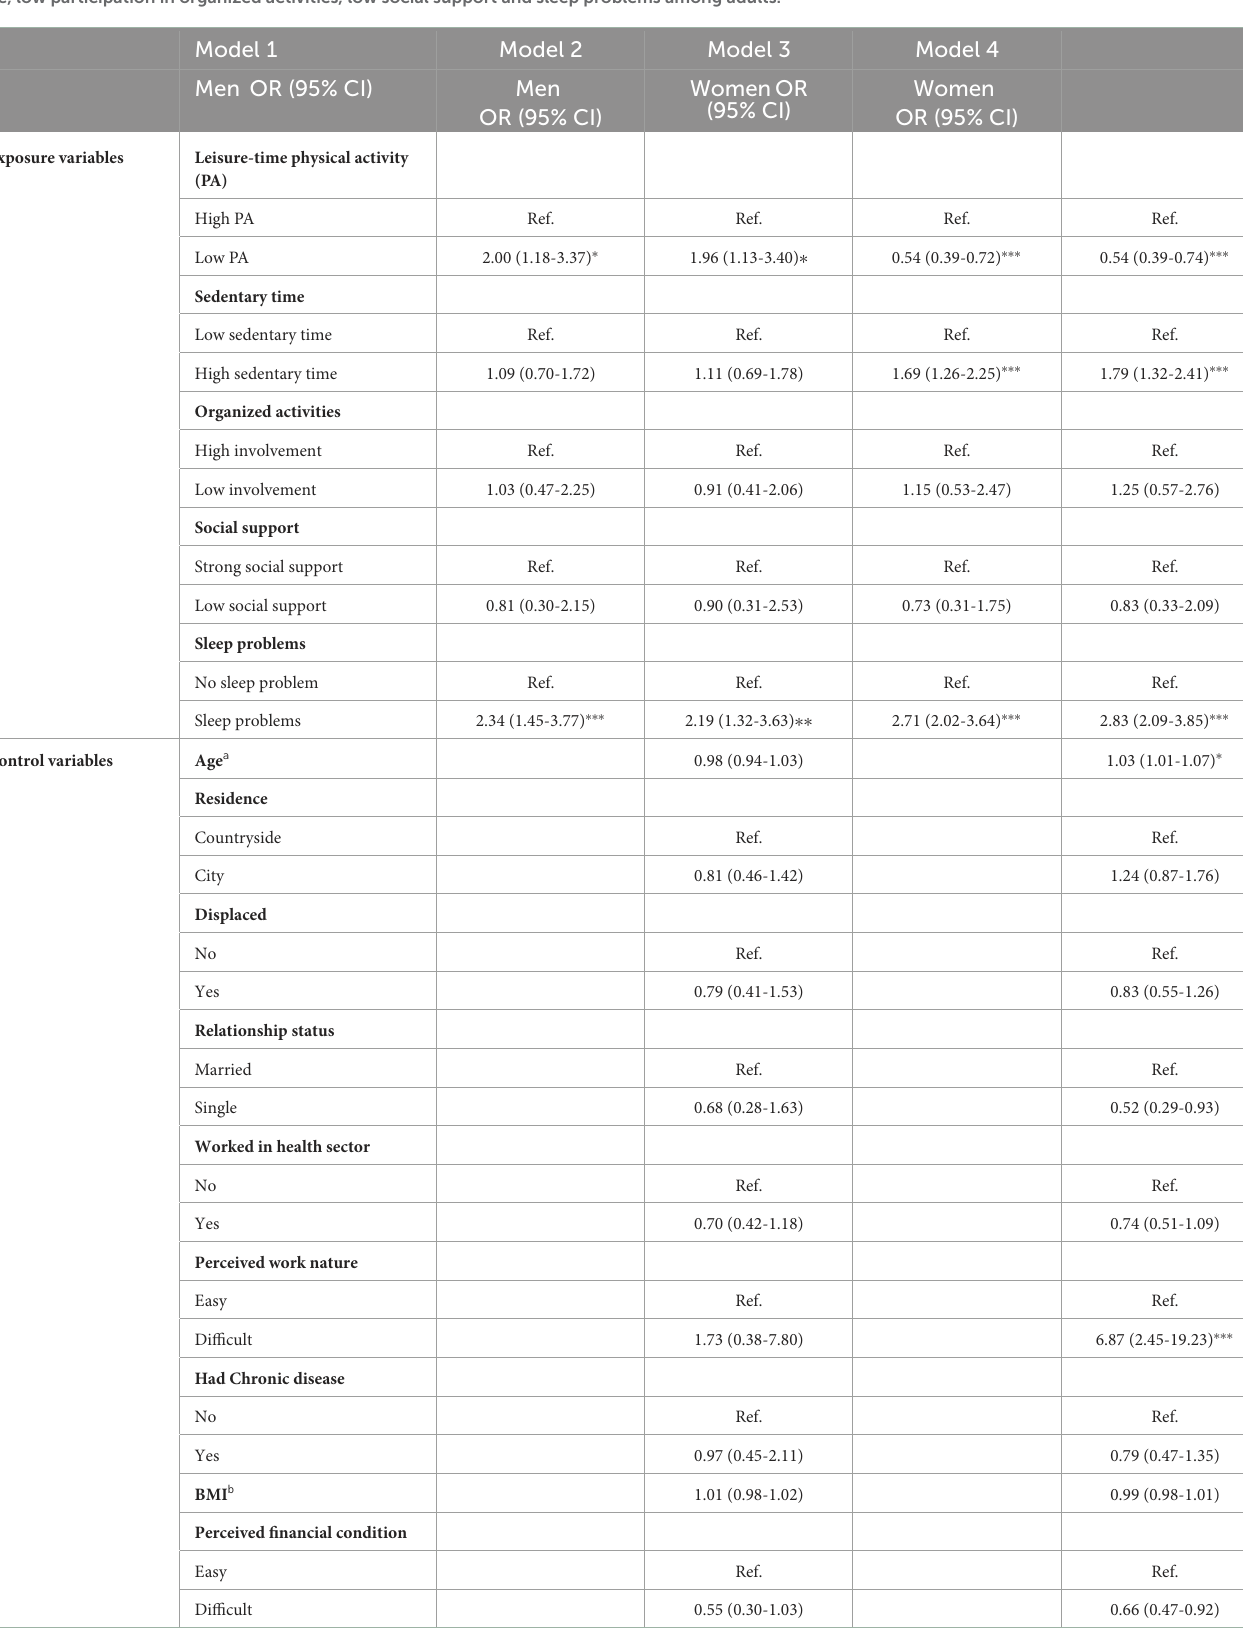
TABLE 3 Adjusted odds ratio (OR) and 95% confidence interval (CI) for mental distress in relation to low level of leisure-time physical activity, high sedentary time, low participation in organized activities, low social support and sleep problems among